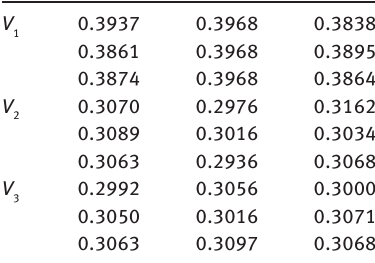
Table 6: The Weights Associated with the Evaluated